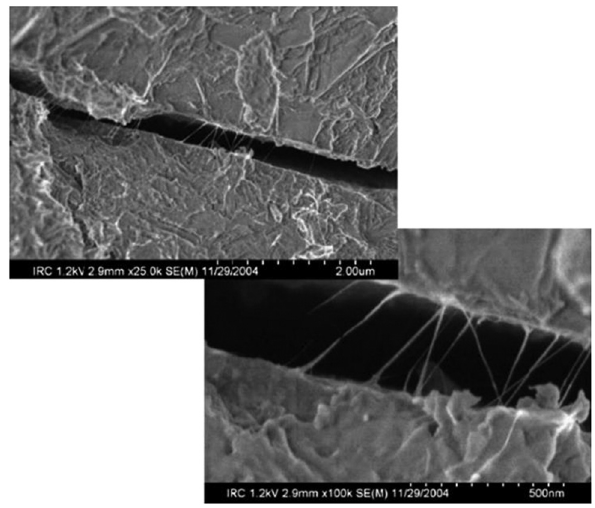
Figure 15: Microscope image of CNTs ’ bridge in cement crack [ 50 ]